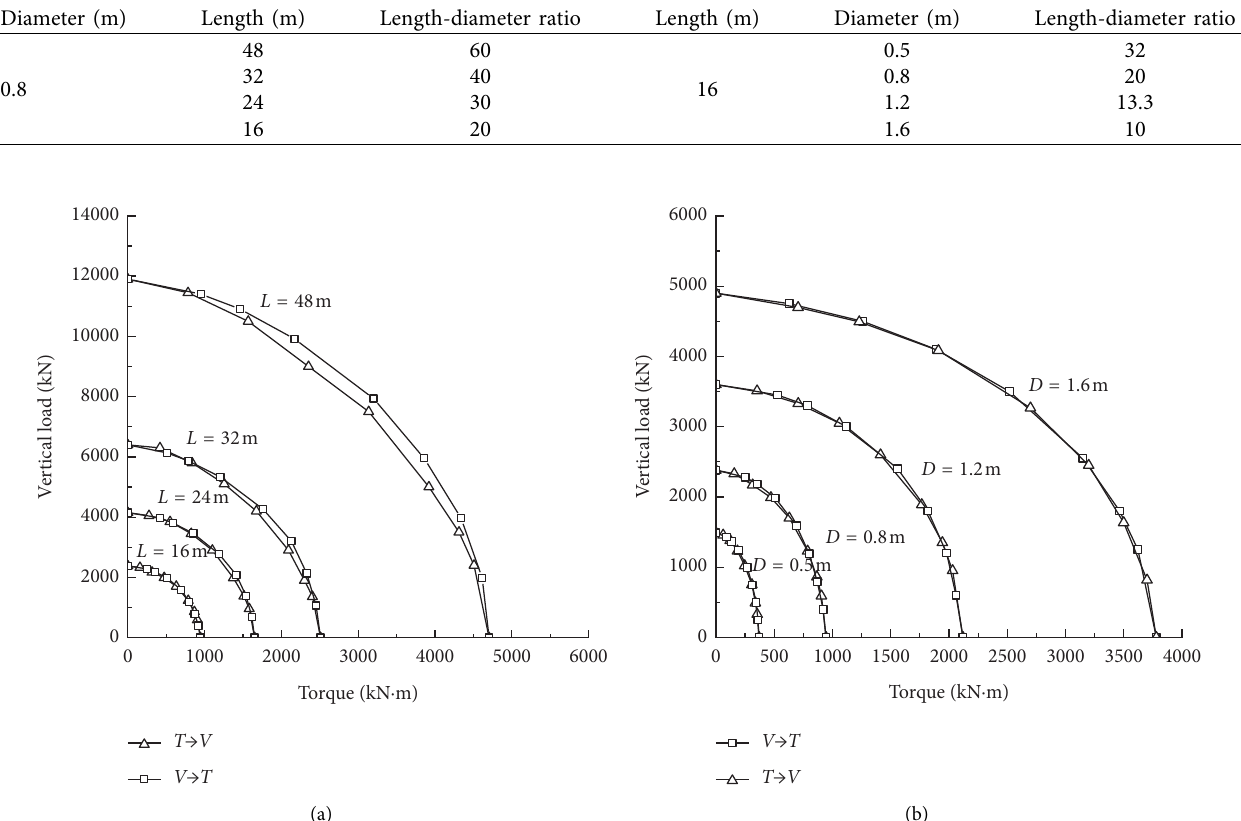
Figure 9: Effect of the pile length and diameter on the envelope of the single pile bearing capacity. (a) Influence of the pile length. (b) Influence of the pile diameter.